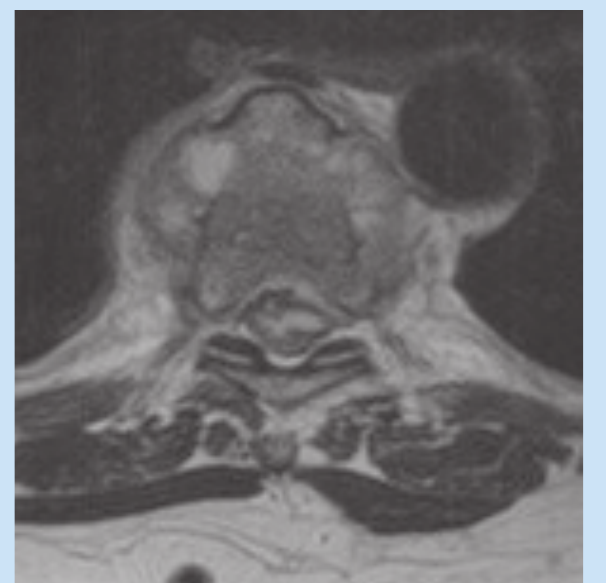
Fig 4a. T2 axial image.